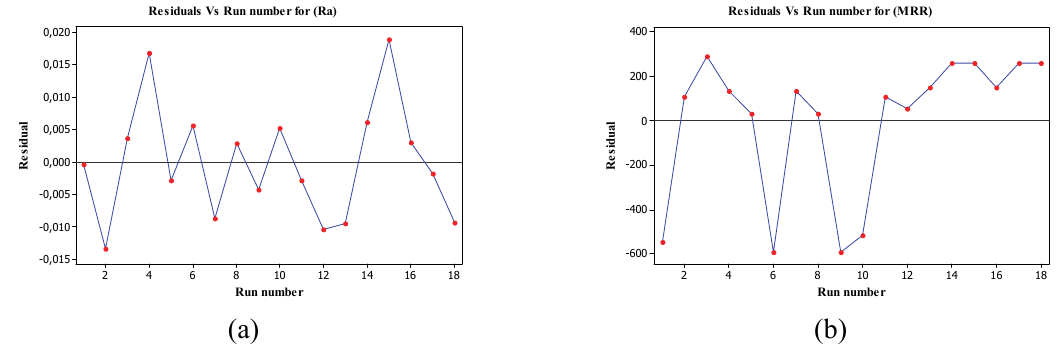
Fig. 9. Plot of residuals vs. run numbers for: (a) surface roughness, (b) removal material rate